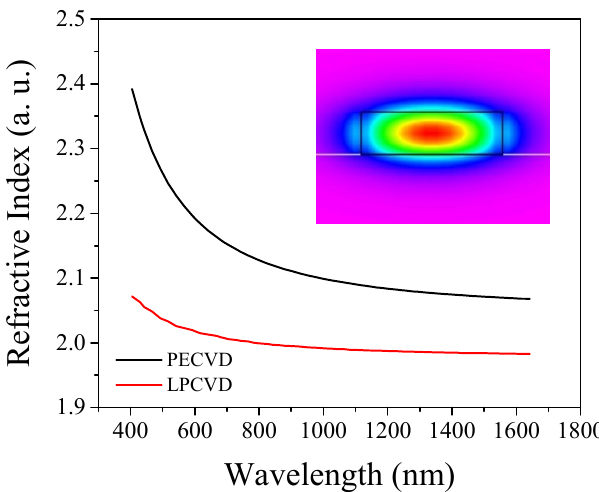
Figure 1. The refractive index of silicon nitride prepared by PECVD and LPCVD. The insert is the optical field distribution of the fundamental TE mode, here, the width, thickness, and refractive index of silicon nitride are 710 nm, 1250 nm and 2.0, respectively.